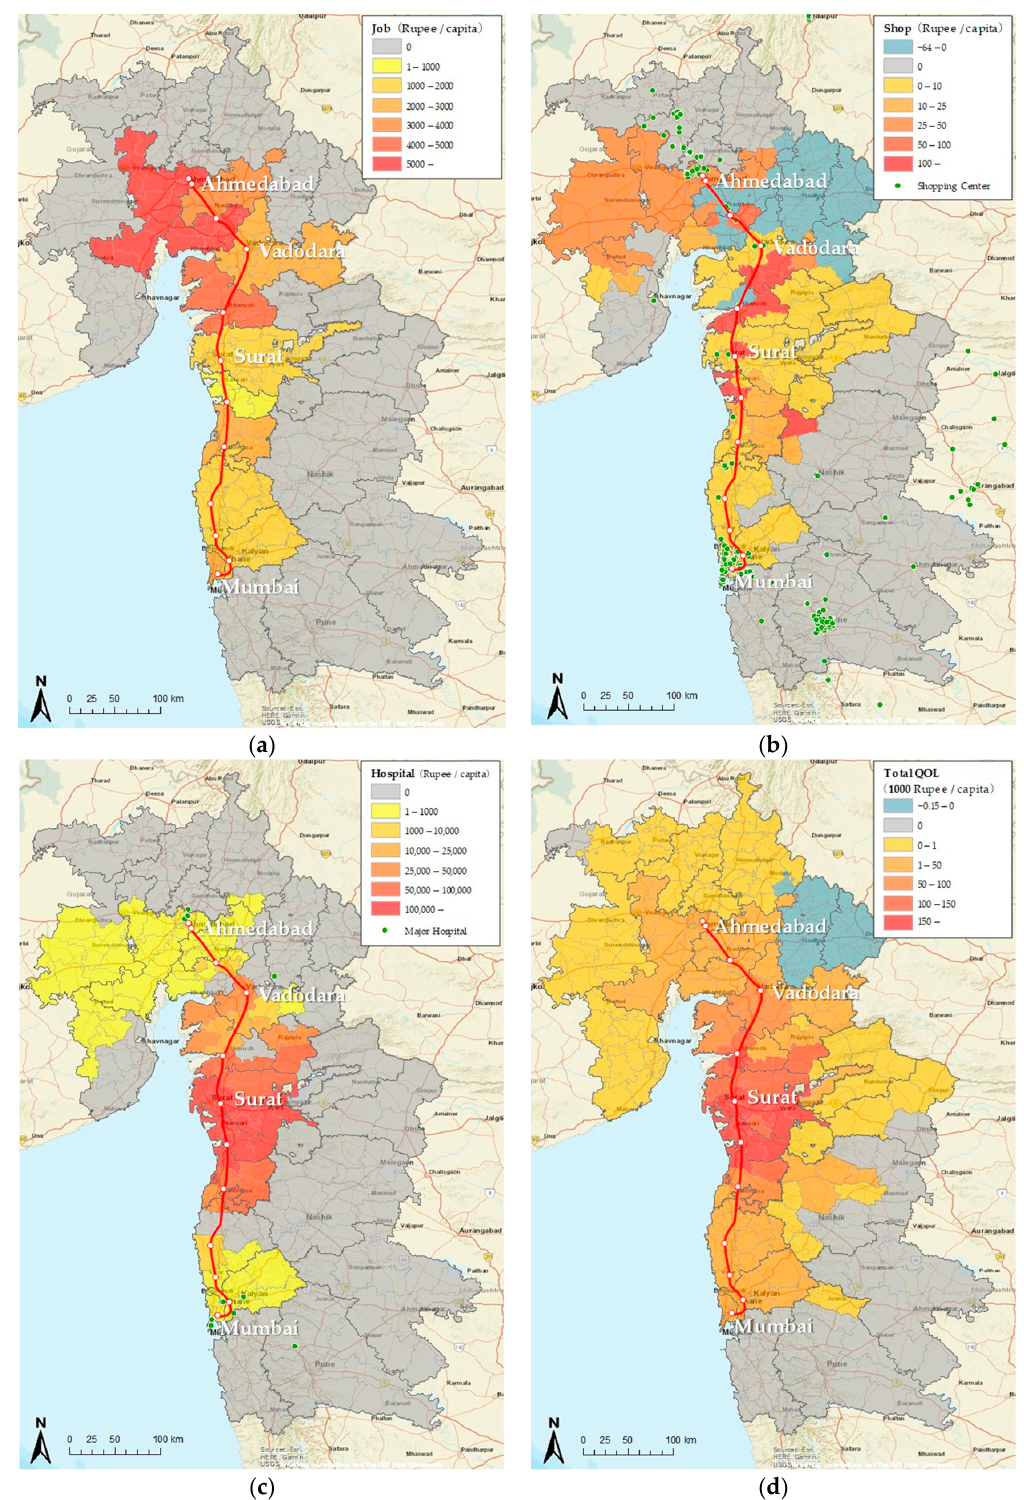
Figure 6. Estimated QOL impacts distribution in the MAHSR corridor by: ( a ) job opportunities; ( b ) travel time to shopping centers; ( c ) travel time to major hospitals; ( d ) total QOL ( sources: the authors visualized the results based on Esri, HERE, Garmin, USGS, Intermap, INCREMENT P, NRCan, Esri Japan, METI, Esri China (Hong Kong), Esri Korea, Esri (Thailand), NGCC, © OpenStreetMap contributors, and the GIS User Community).